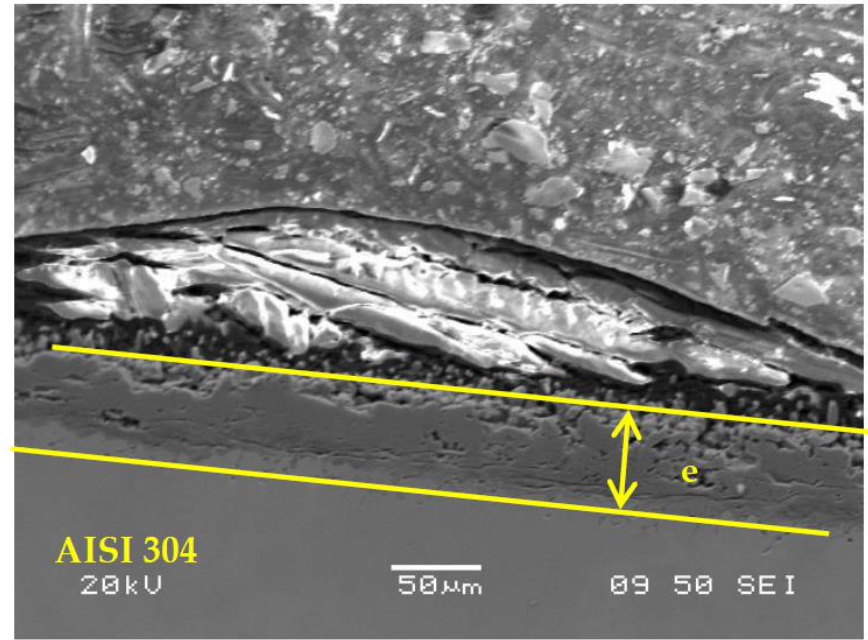
Figure 14. Oxide layer in AISI 310 sample.